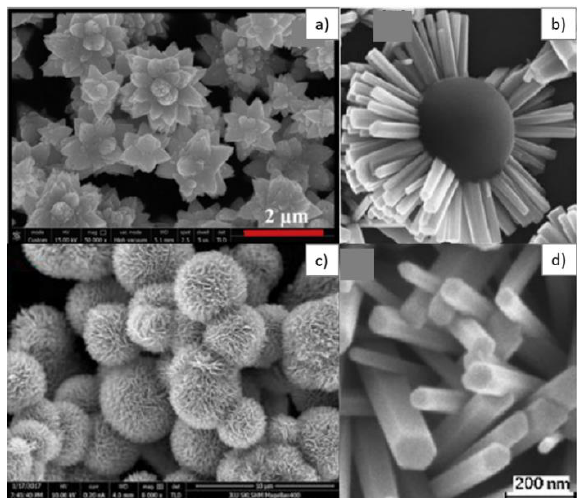
Figure 6. SEM images for ZnO obtained by the hydrothermal method for different morphologies: nanoflowers ( a , c ) [84,164], nanowires ( b , d ) [91]. Reproduced (2020) with permission from Elsevier.